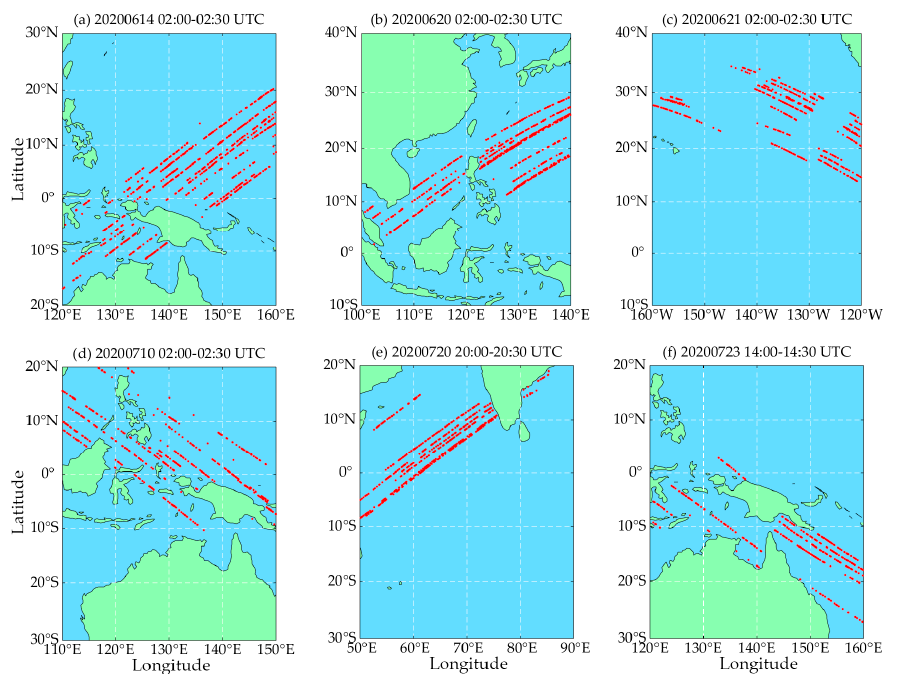
Figure 10. Test data set distribution. a region corresponding to Figure 11a (2020 0614 UTC: 02:00–02:30), b region corresponding to Figure 11b (20200620 UTC: 2:00–02:30), c region corresponding to Figure 11c (20200621 UTC: 2:00–02:30), d region corresponding to Figure 11d (20200710 UTC: 2:00–02:30), e region corresponding to Figure 11e (UTC:20200720 20:00–20:30), and f region corresponding to Figure 11f (UTC:20200723 14:00–14:30).